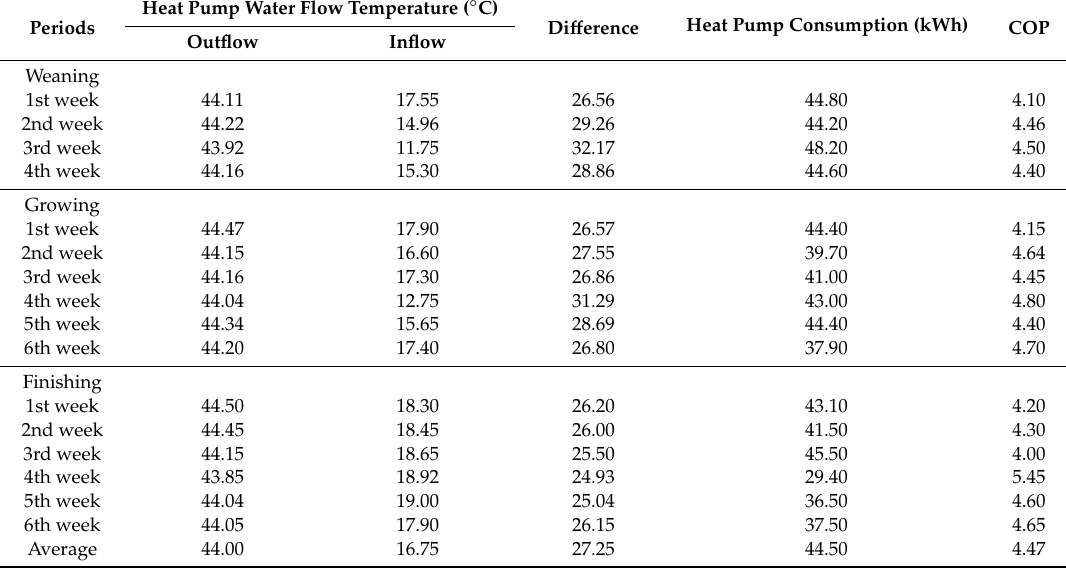
Table 2. Coe ffi cient of performance (COP) of the geothermal heat pump (GHP) during heating.